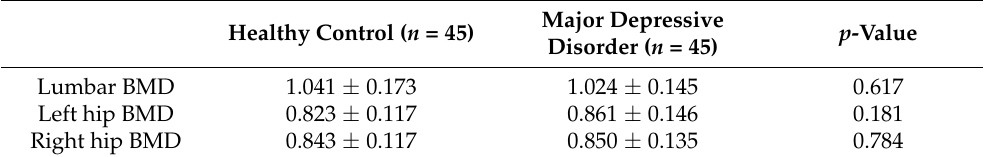
Table 2. Comparison of the mean BMD between patients with MDD receiving SSRI treatment and healthy controls.